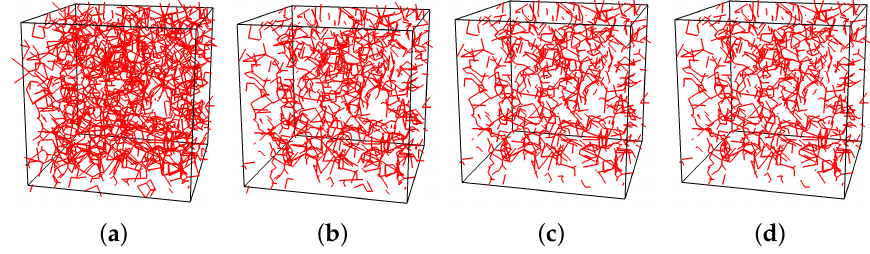
Figure 11. Constrained swelling analysis: spatial distribution of pipes with r p > 5 µ m at the four stages marked in Figure 7 to Figure 9. The capillary suction values of the four stages are ( a ) 6.61 × 10 3 , ( b ) 2.37 × 10 3 , ( c ) 1.43 × 10 3 and ( d ) 0.36 × 10 3